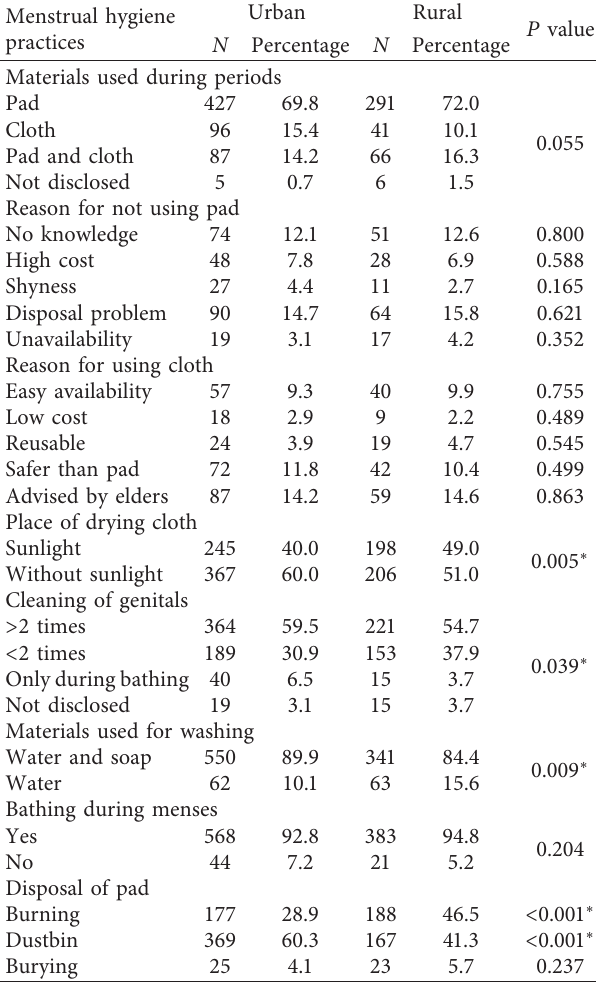
Table 1: Characteristics of the menstrual cycle and menstruation in the participants. Age of menarche in years